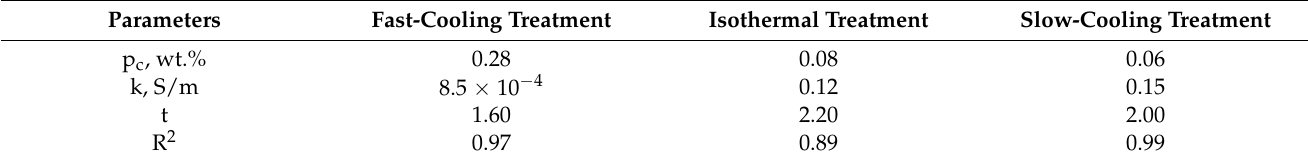
Table 1. Percolation threshold and fitting values of experimental data according to Equation (1) for PP/PS/MWCNTs composites after each treatment.